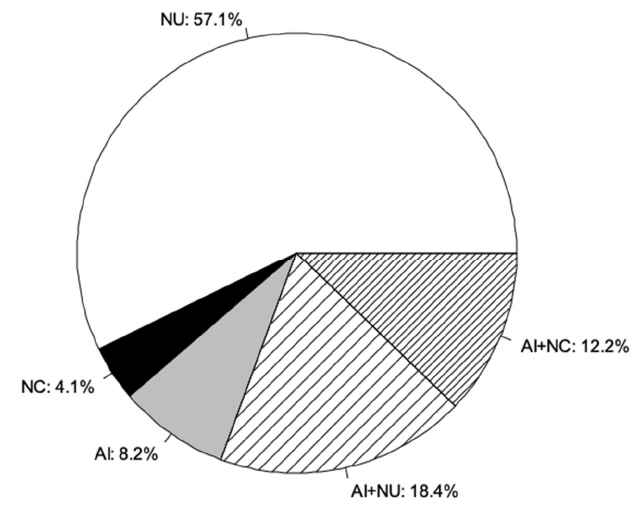
Figure 2. Mating methods used by cattle breeders in Ouagadougou ( n = 49). NU: uncontrolled natural mating, NC: controlled natural mating, AI: artificial insemination.